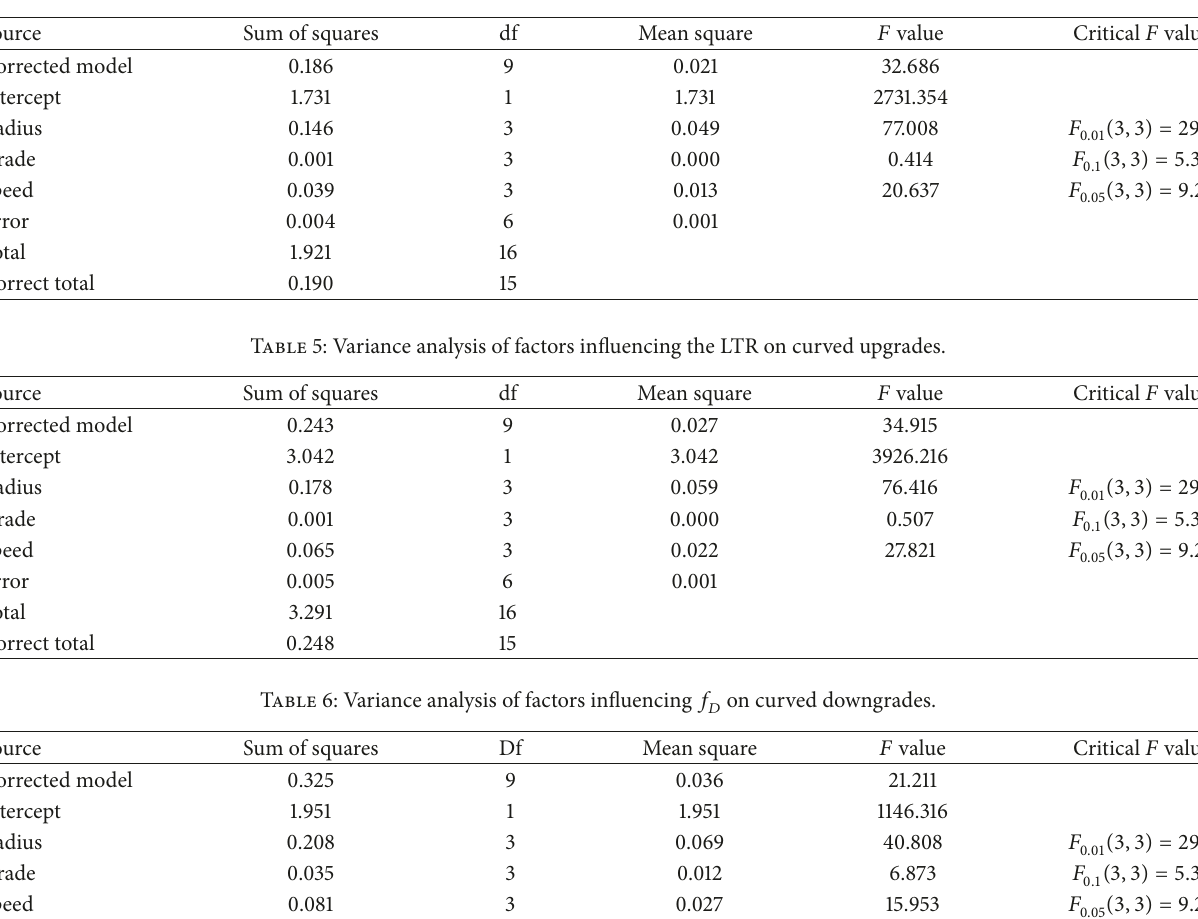
Table 4: Variance analysis of factors influencing 𝑓 𝐷 on curved upgrades.